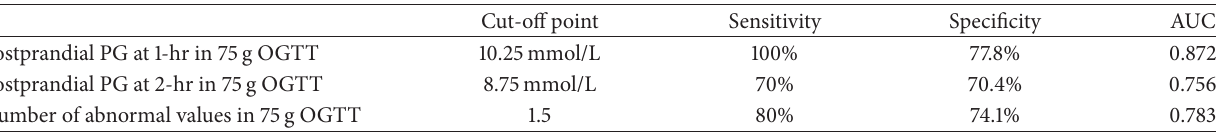
Table 4: The cut-off values of 1-h and 2-h plasma glucose levels and the number of abnormal values to predict antenatal insulin treatment (AIT).